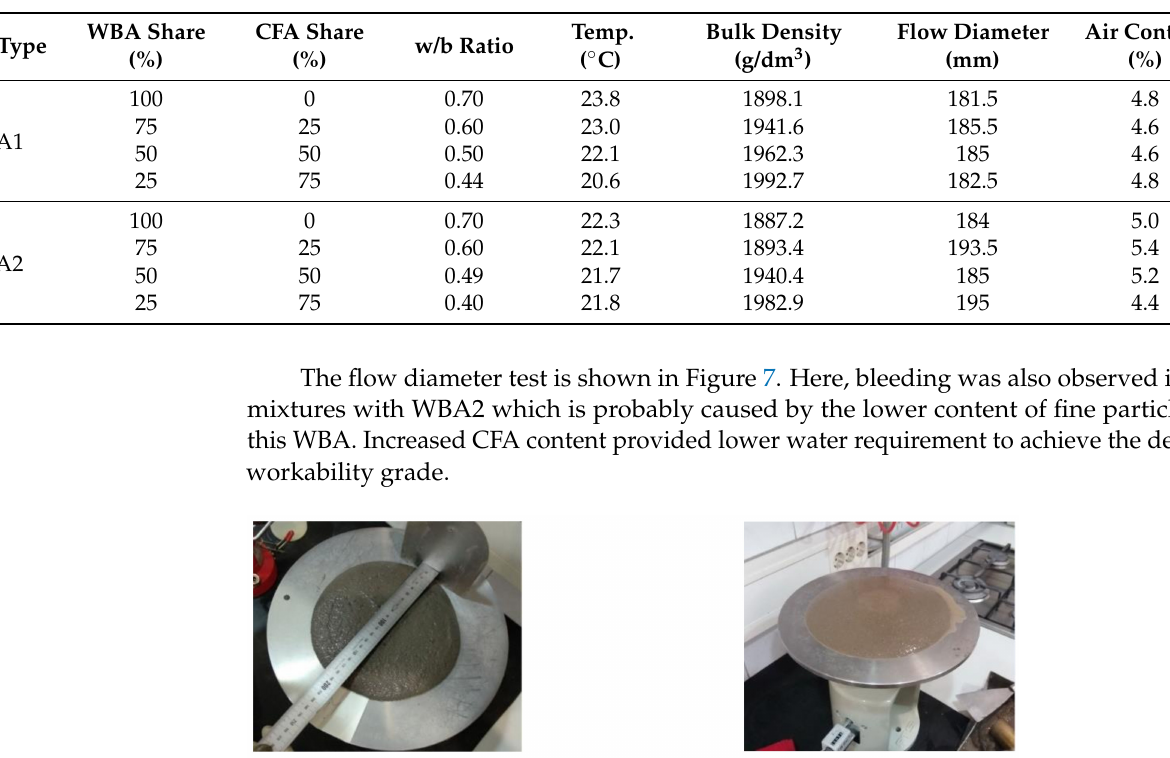
Table 7. Fresh state properties of mortars.